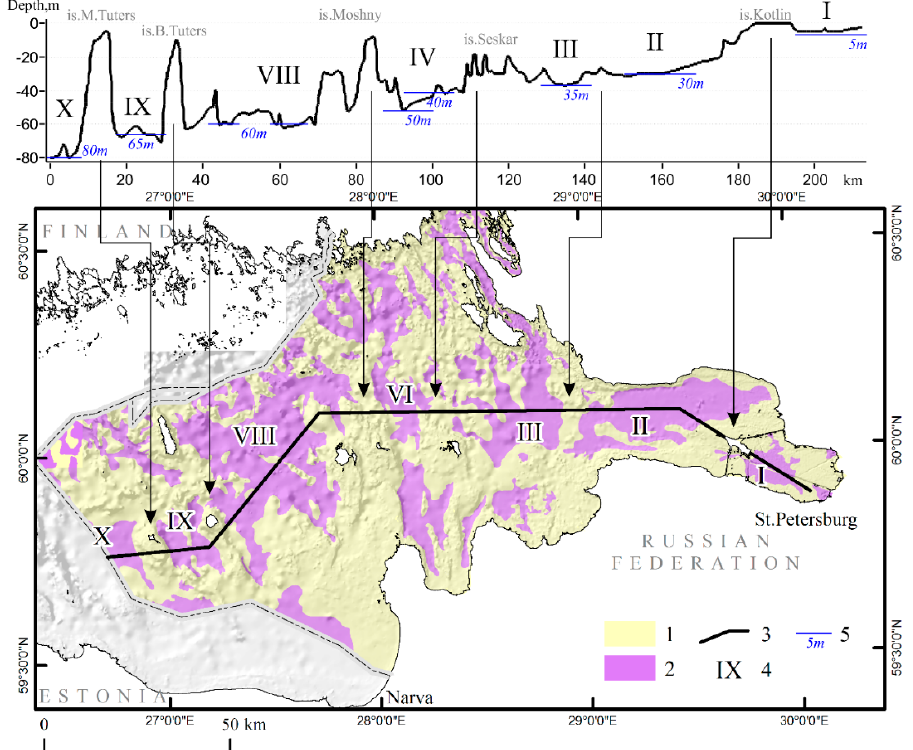
Figure 12. Schematic representation of the sedimentary basins in the Eastern Gulf of Finland: 1 = areas of submarine erosion and non-sedimentation, 2 = sediment basins with silty-clayey mud accumulation, 3 = cross-section profile line, 4 = sedimentary basin number, 5 = mean level of the modern clayey mud surface. Sediment basins are located along a ladder-shape profile, which steps down from depths of 5 to 6 m in the Neva Bay to 80 m south of Gogland Island and is separated by vast areas of non-sedimentation and erosion.